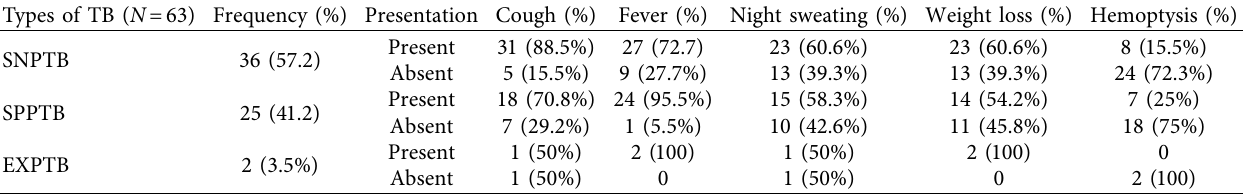
Table 4: Clinical presentations of seropositive children before confirmed PTB/TB diagnosed in selected public facility Northwest Ethiopia,